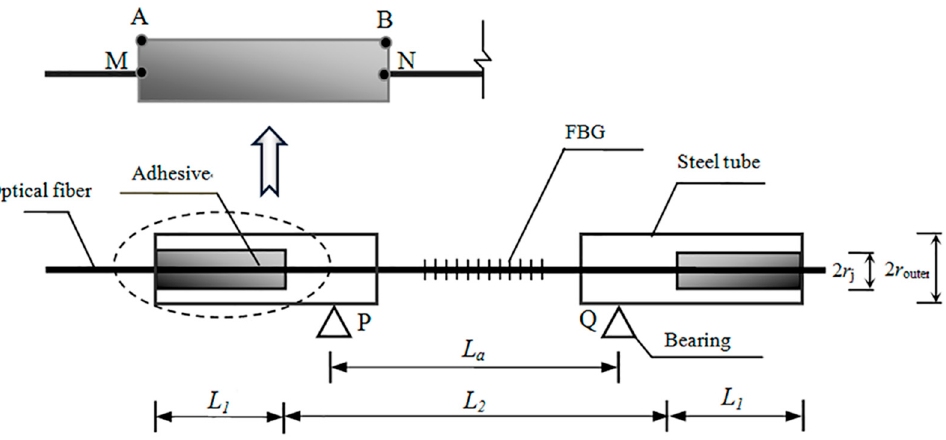
Figure 2. Schematic diagram of wide-range FBG sensor.